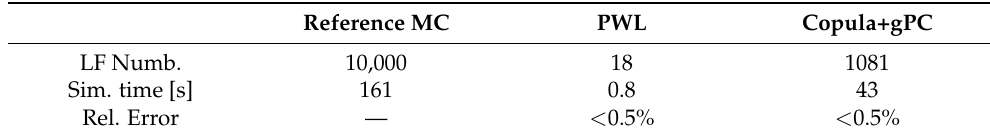
Table 2. Methods Comparison.